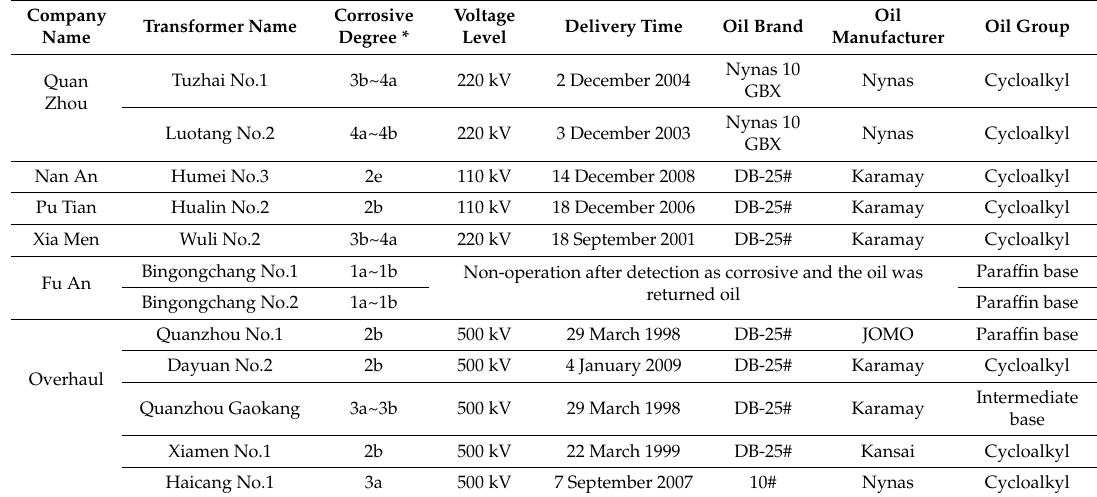
Table 1. Investigation statistics of corrosive oil samples in Fujian power